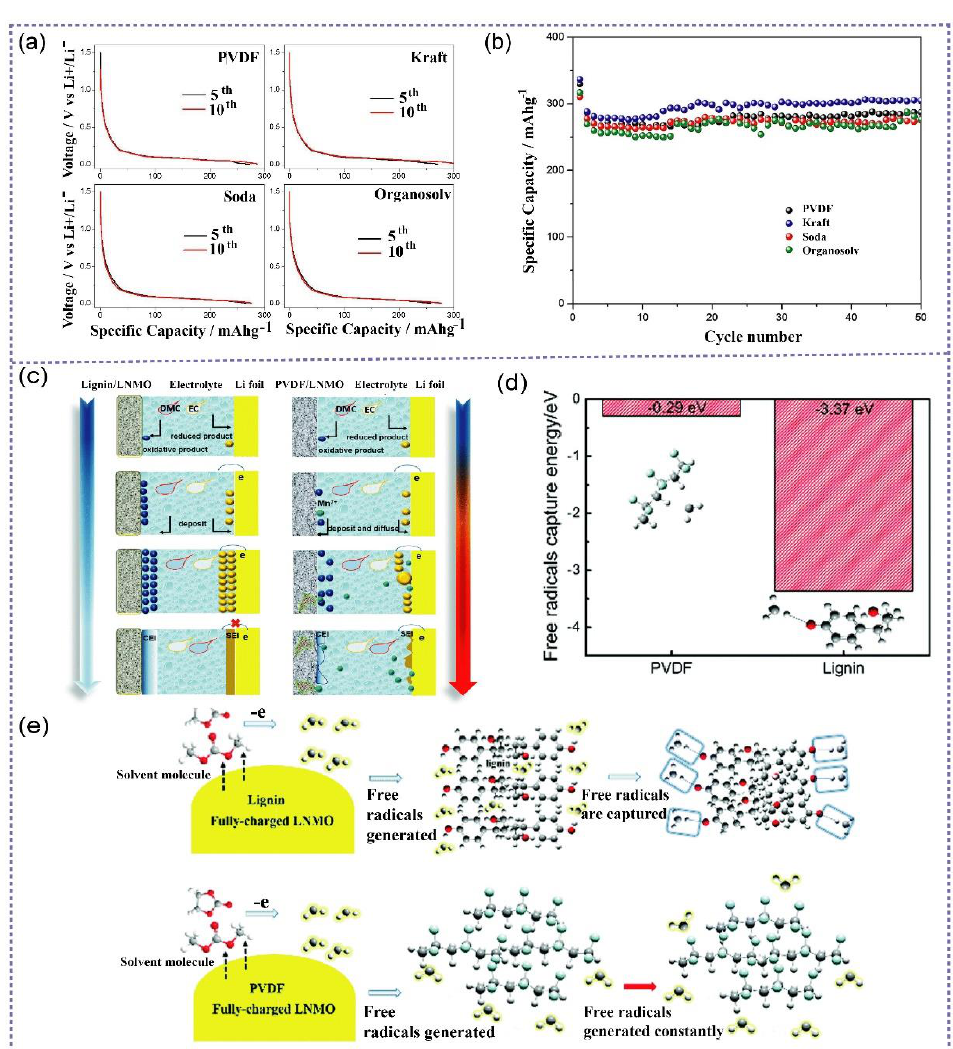
Figure 4. ( a ) The 5th and 50th discharge curves of four electrodes at 100 mA g − 1 . ( b ) Capacitance retention of four electrodes at C/4 rate after 50 cycles. ( c ) Schematic representation of the membrane forming process based on lignin and PVDF binder. ( d ) Potential energy map of the reaction of the free radicals with the lignin/PVDF binder. ( e ) Diagram of the free radical removal process for the lignin and PVDF binders (From Refs. [66,67]).